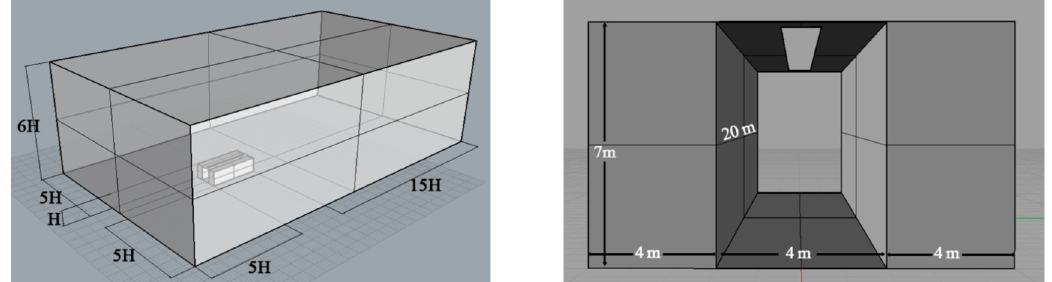
Figure 4. The model was placed in a computational domain with dimensions 147 m × 85 m × 45 m as X, Y, and Z (length, width, and height).